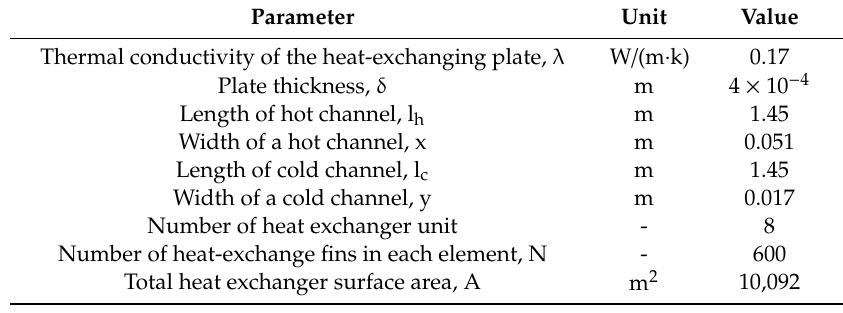
Table 2. Design parameters of the free space cooling tower (FSCT)-type VCPA device.